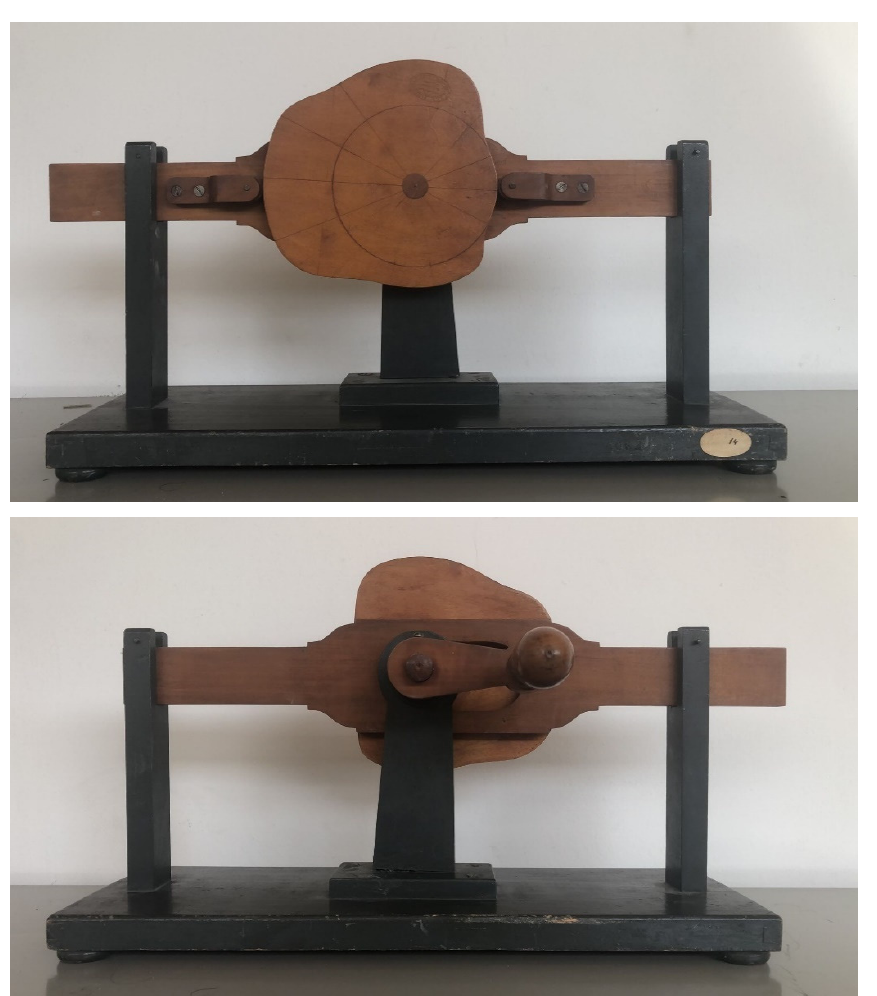
Figure 13. Front and rear view of a multilobes cam that transforms the rotation of the input cam into and alternative motion of the rod.